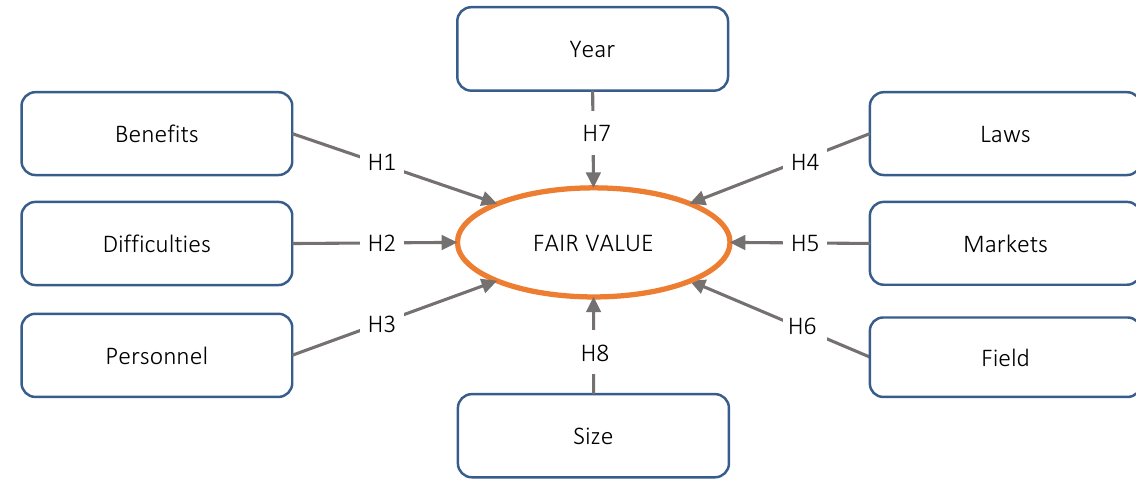
Figure 1. Conceptual framework